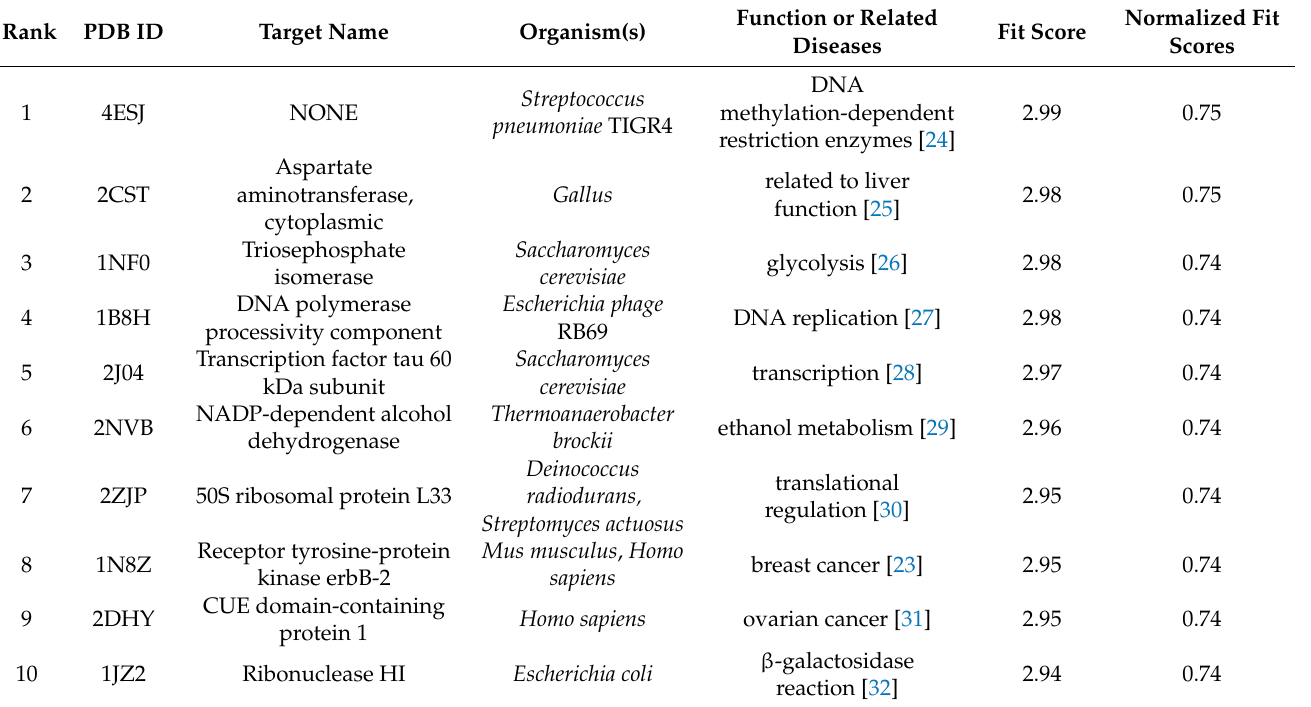
Table 3. Top 10 targets of protein No. 1 and their function.